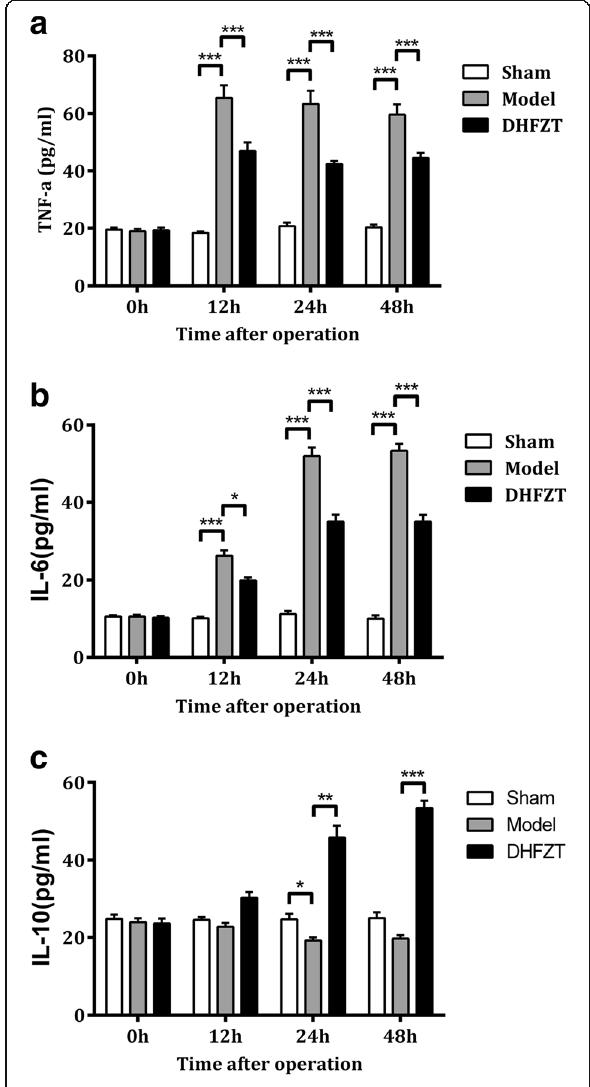
Fig. 6 DHFZT affected the changes of serum concentrations of TNF- α , IL-6 and IL-10 after SAP. Sham: sham group; Model: Severe acute pan- creatitis group; DHFZT: DHFZT group. Serum concentrations of TNF- α , IL-10, and IL-6 were determined using enzyme linked immunosorbent assay. TNF- α : tumor necrosis factor- α ; IL-6: interleukin-6; IL-10: interleukin-10. Data are expressed as means ± SEM. * P < 0.05, ** P < 0.01, *** P <